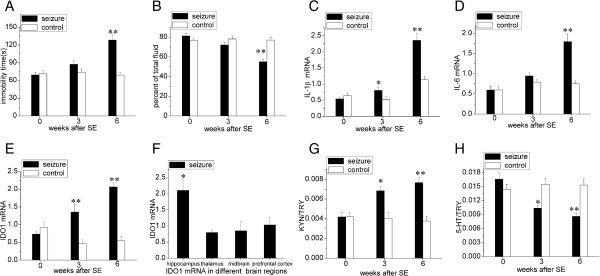
Chronic temporal lobe epilepsy-induced depressive behaviors, upregulated IL-1β, IL-6 and indoleamine 2,3-dioxygenase expression, and altered tryptophan metabolites. (A) The duration of immobility during the forced swim test was increased in chronic epileptic rats at 6 weeks after status epilepticus (SE) compared with the controls. (B) Saccharin consumption, calculated as a percentage of the total fluid intake over 24 hours, was diminished at 6 weeks after SE. (C) IL-1β mRNA levels were gradually increased in chronic epileptic rats at 3 and 6 weeks after SE. (D) IL-6 mRNA levels were increased in chronic epileptic rats at 6 weeks after SE. (E) Indoleamine 2,3-dioxygenase 1 (IDO1) mRNA levels were also upregulated in chronic epileptic rats at 3 and 6 weeks after SE. (F) IDO1 mRNA levels were primarily upregulated in the hippocampus compared with the thalamus, midbrain and prefrontal cortex, and compared with the controls. (G) The kynurenine (KYN)/tryptophan (TRY) ratio was elevated and (H) the serotonin (5-HT)/TRY ratio was reduced in chronic epileptic rats at 3 and 6 weeks after SE. All the data at 0 weeks are baseline values (naive rats). Statistical significance was determined using independent samples t-test and one-way analysis of variance. The data are presented as means ± SEM, n = 5 to 6; *P < 0.05; **P < 0.01.